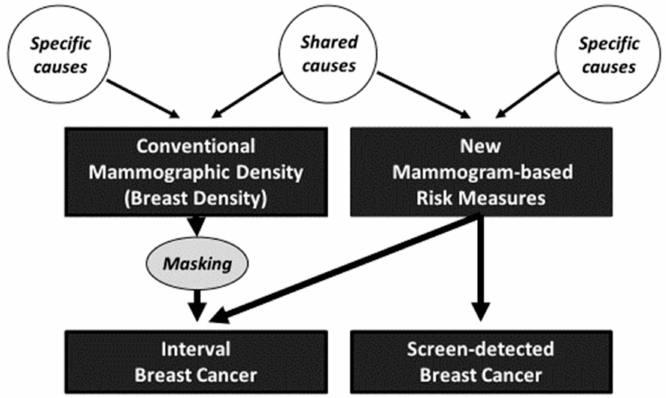
Figure 1. Path diagram indicating causal pathways implicated in conventional and new mammogram-based predictors of interval and screen-detected breast